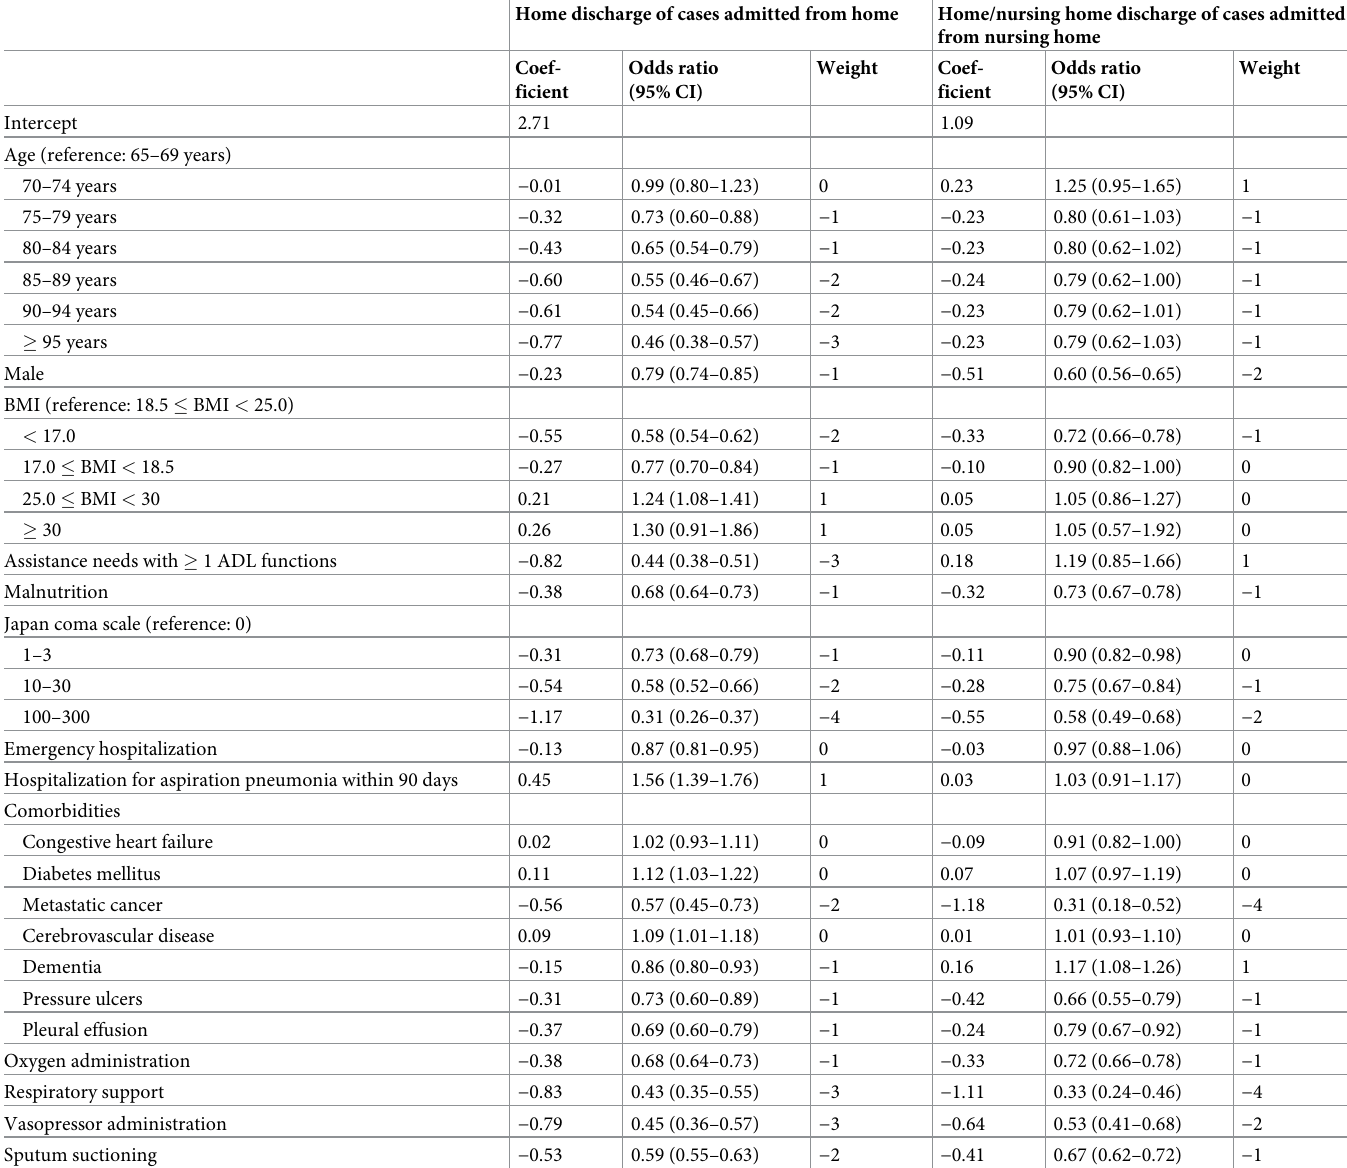
Table 2. Regression coefficients, odds ratios, and derived weights for each predictor of the two outcomes according to residence before admission in the derivation cohort. Home discharge of cases admitted from